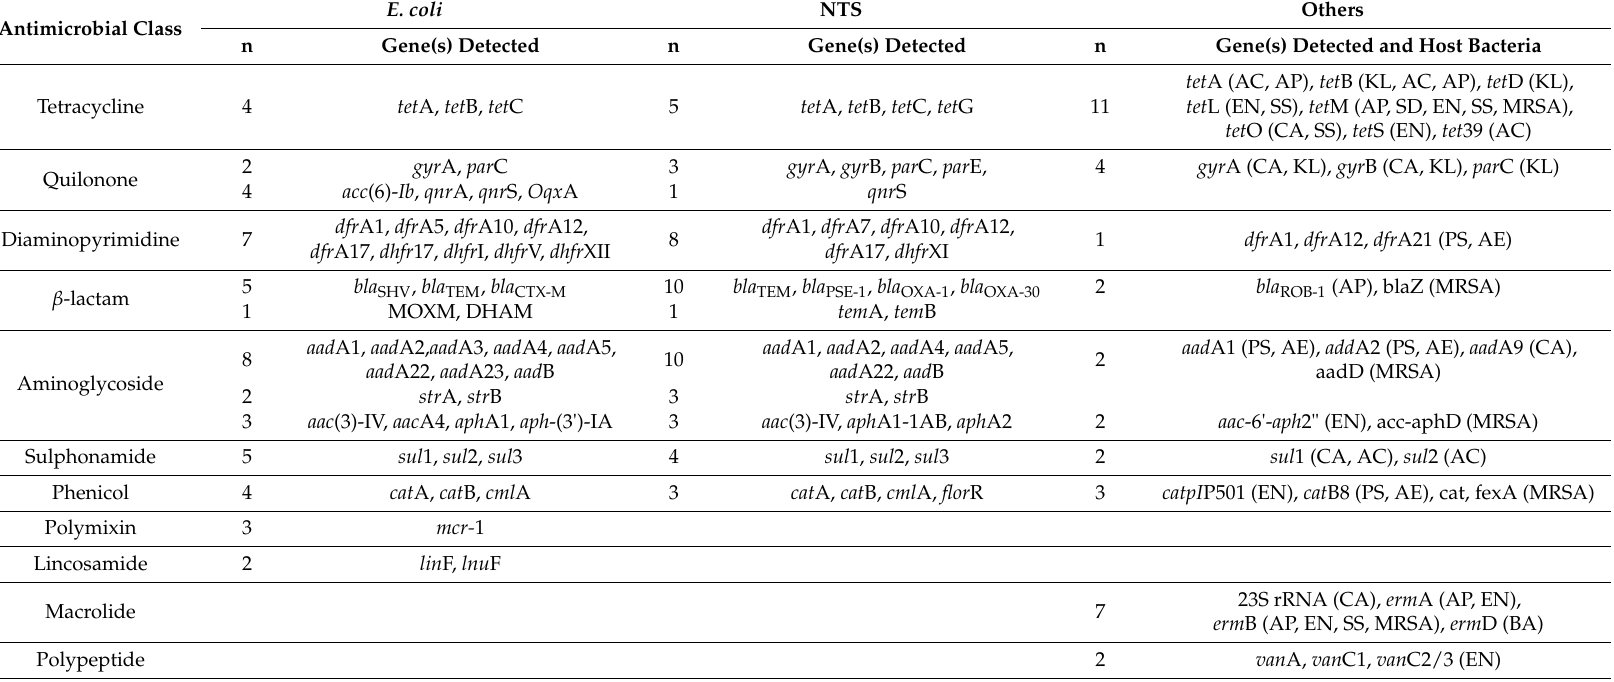
Table 4. Antimicrobial resistance (AMR) genes identified in bacterial isolates reported in 33